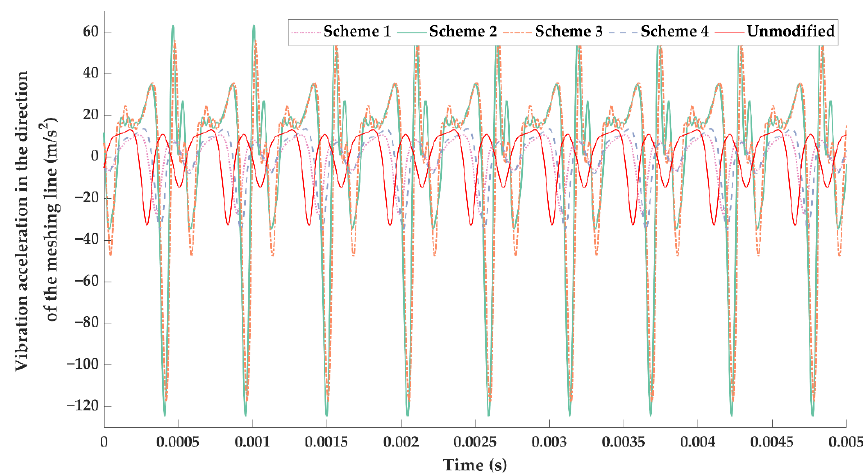
Figure 20. Vibration acceleration in the direction of the gear meshing line at a load of 100 N·m.